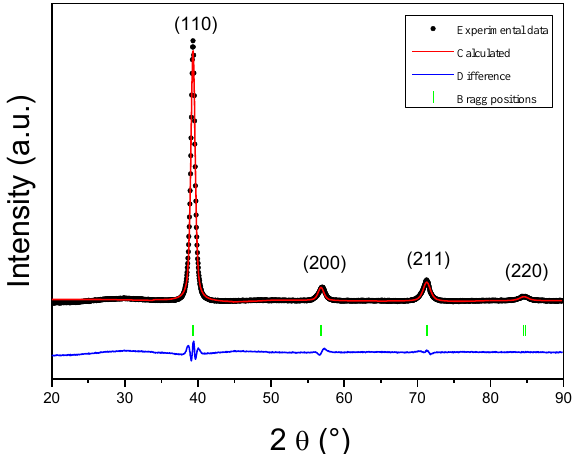
Figure 1. X-ray diffraction pattern (λ= 1.5406 Å) with the corresponding Rietveld analysis of the as-cast Ti 0.30 V 0.25 Zr 0.10 Nb 0.25 Mo 0.10. This alloy is single-phased with a bcc lattice.